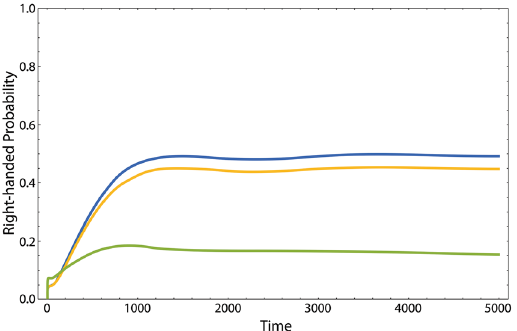
Figure 7. The dynamics of the right-handed state of the open chiral molecule in the aqueous bath at fixed tunneling frequency ω the left-handed one. Note that all parameters are made dimension-less with respect to the relevant characteristic parameters of the molecule. The figure is updated from ref.